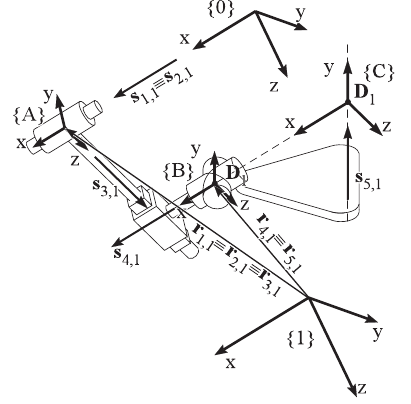
Figure 4. Unit screws of each kinematic